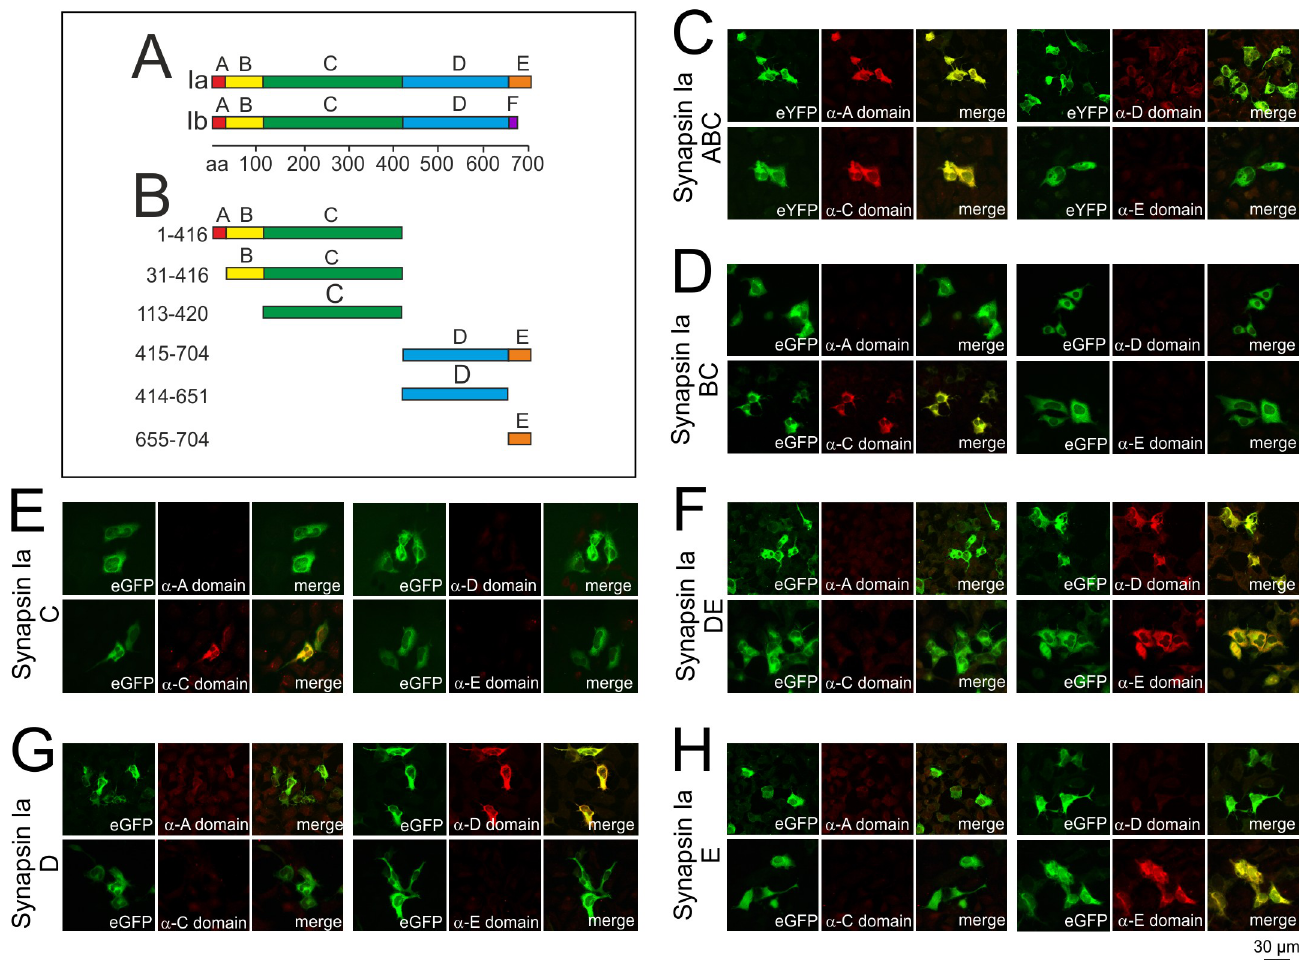
Fig 1. Specific recognition of synapsin I domains expressed in transfected HEK cells by domain-specific antibodies. (A) Domain structure of the synapsin isoforms Ia and Ib. The N-terminal domains A-C are highly conserved in all synapsins. The C-terminal region is variable due to heterogeneous combinations of domains. (B) Diagram of the synapsin Ia fragments examined to investigate targeting of patient synapsin autoantibodies. (C-H) HEK293 cells were transfected with rat synapsin Ia constructs, comprising the eYFP-tagged fragment ABC (C), eGFP-tagged BC (D), eGFP-tagged C (E), eGFP-tagged DE (F), eGFP-tagged D (G), or eGFP-tagged E domain (H). Cells were fixed, permeabilized and incubated with antibodies either directed against the A-domain of synapsin I and II (rabbit anti-synapsin A; dilution 1:500), the D-domain of synapsin I (mouse anti-synapsin D; dilution 1:500), the C-domain of synapsin I/II (rabbit anti-synapsin C; dilution 1:500), or the E-domain of synapsin Ia (rabbit anti-synapsin E; dilution 1:200). Antibody binding was visualized using Alexa Fluor 549-coupled secondary antibodies. Transfected cells were correctly recognized by the respective antibodies that colocalized with the signal of the tags, confirming domain identities and detectability of the various domains by anti-synapsin